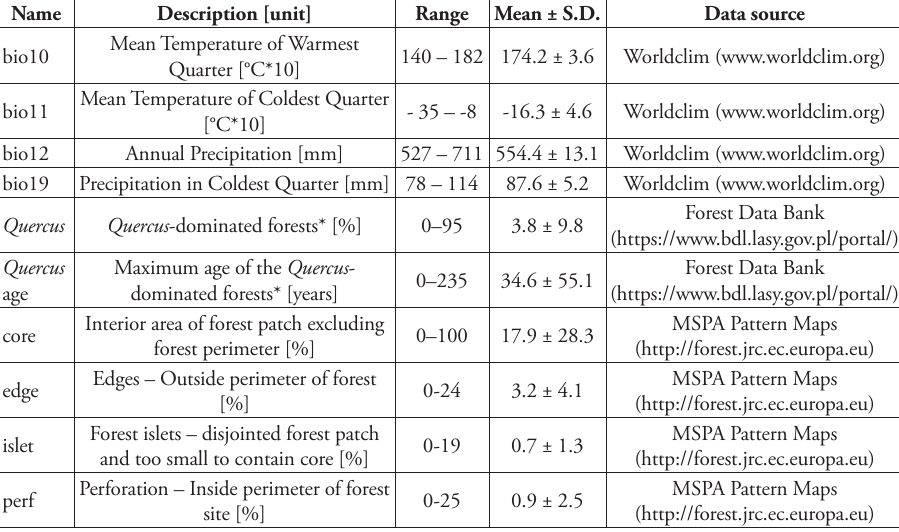
Table 1. The environmental variables used in ecological niche modelling of Cerambyx cerdo L., 1758 in south-western